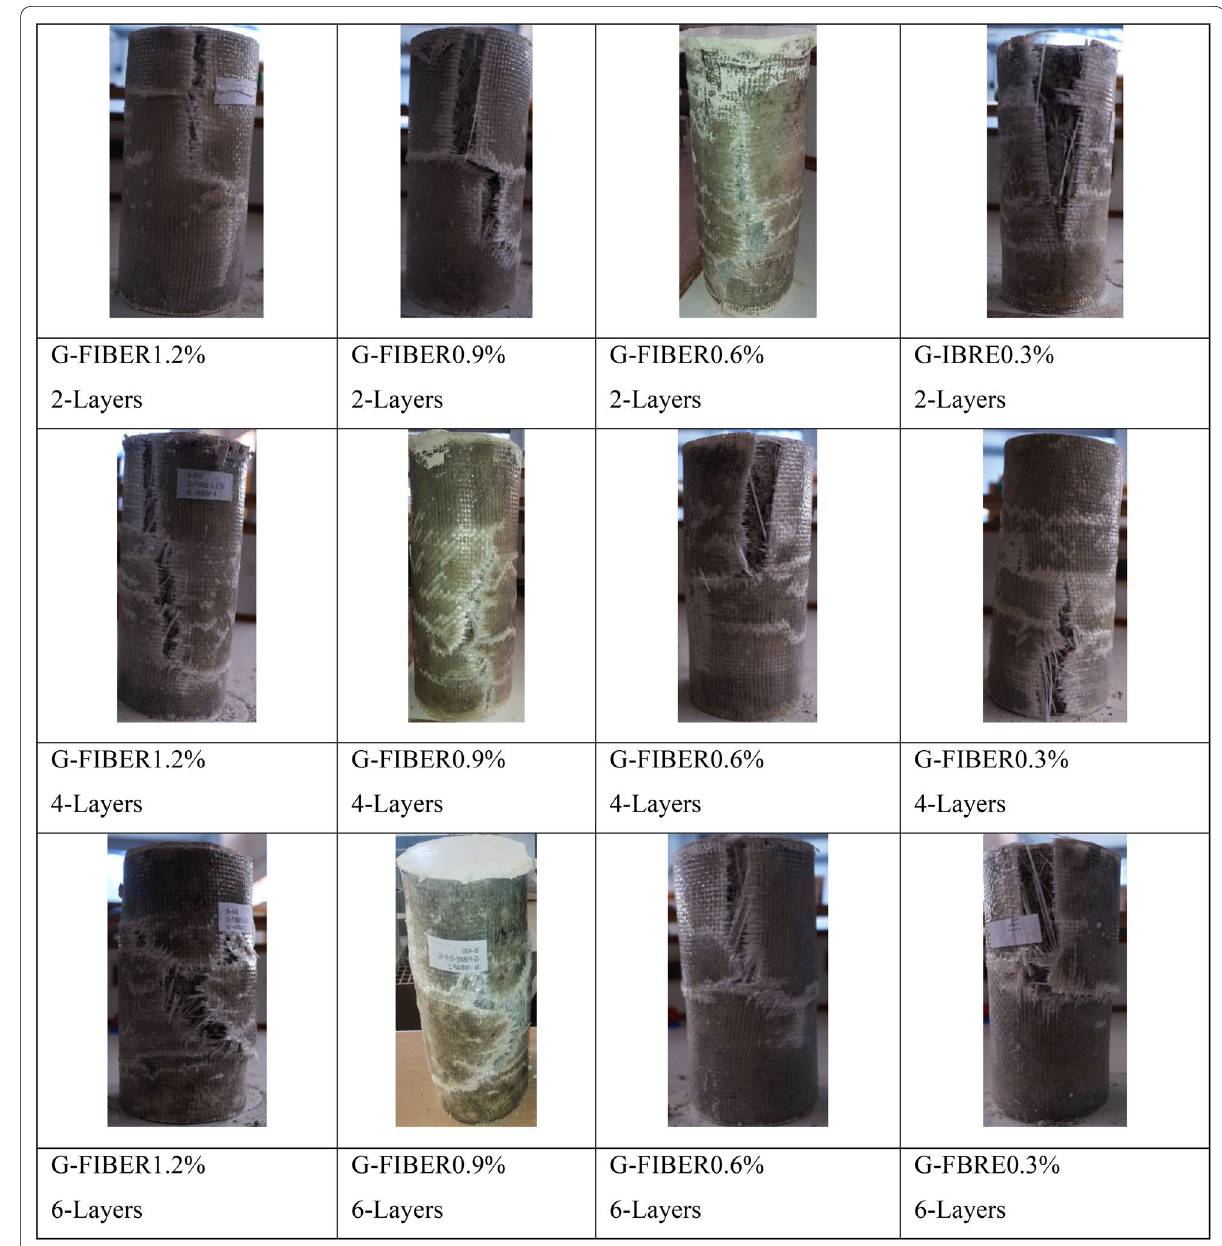
Fig. 6 Typical failure modes of test cylinders (strength concrete